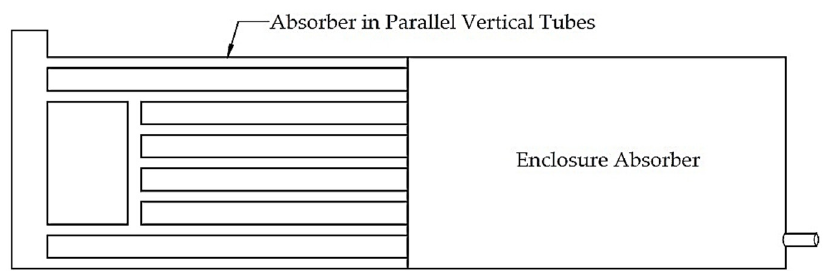
Figure 8. A modification of harp ST-PVT with a combination of two thermal absorbers, redrawn from El Hocine et al. [104].